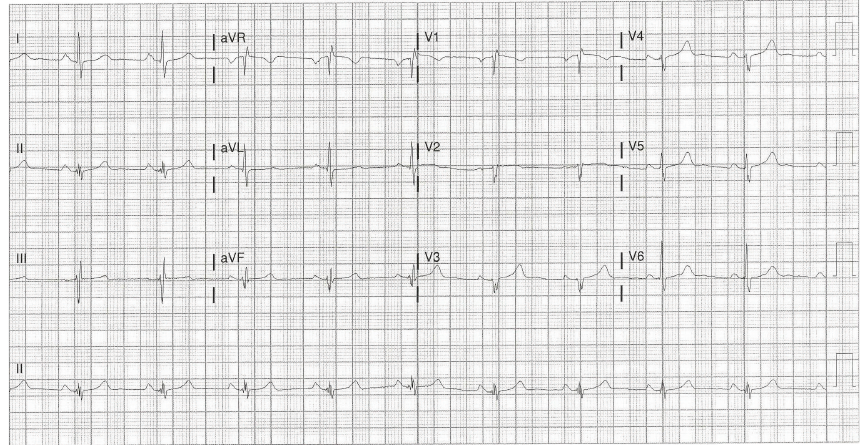
Figure 2: Baseline ECG. ECG recording speed of 25 mm/s.